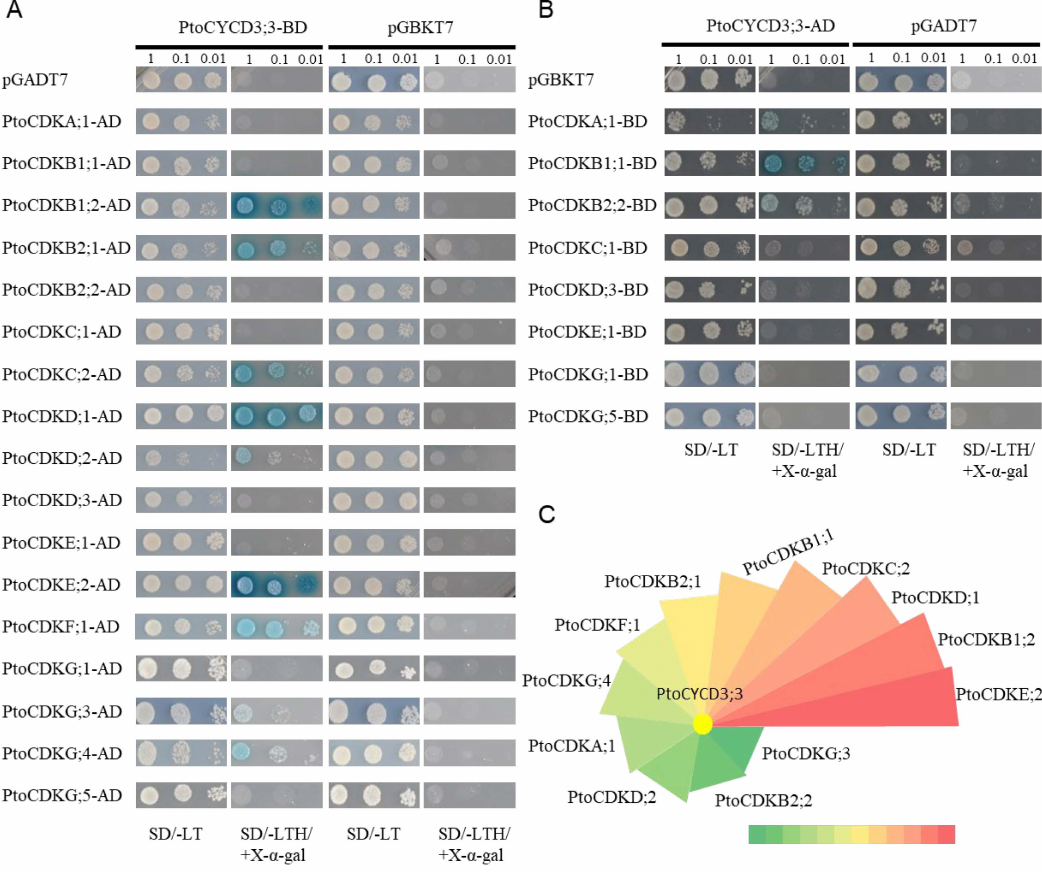
Figure 7. Protein–protein interactions of PtoCYCD3;3 with CDKs. ( A , B ) Yeast cells were co-transfected with pGBKT7 and pGADT7 constructs carrying the corresponding genes and grown on SD/-Leu/-Trp or SD/-Leu/-Trp/-His/+x- α -gal. pGADT7 + PtoCYCD3;3-BD, PtoCDKs-AD +pGBKT7, pGBKT7 + PtoCYCD3;3-AD, PtoCDKs-BD + pGADT7, and pGADT7 + pGBKT7 as negative control. ( C ) Interaction strength of PtoCYCD3;3 with CDKs. The color gradient (green-yellow-red) represents the interaction strength, ranging from the minimum to the